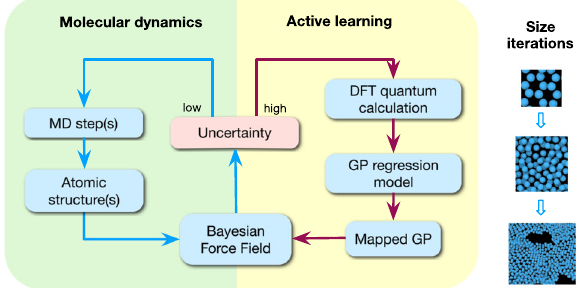
Fig. 1 Bayesian active learning (BAL) work fl ow with MGP. Iterations of BAL can be run for different system sizes to re fi ne the force fi